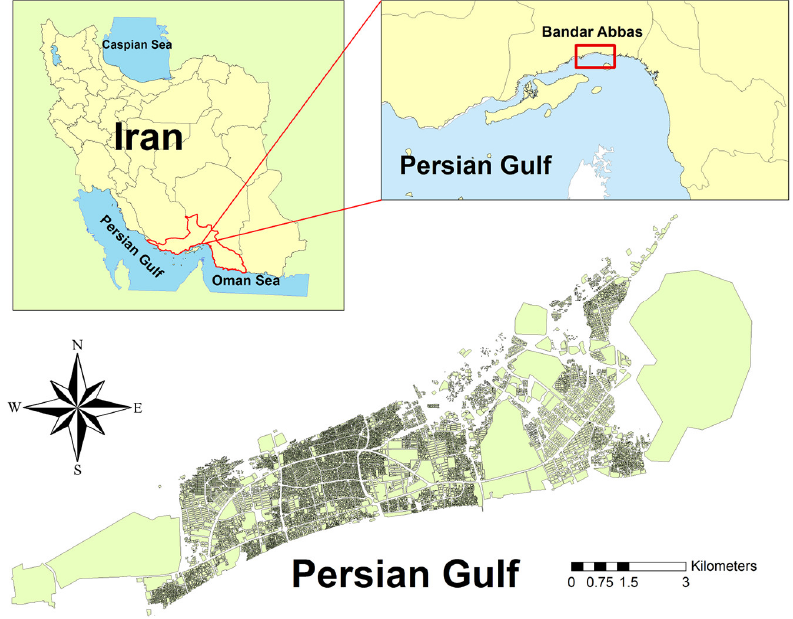
Figure 1. Location of the study area, Bandar Abbas City, Iran